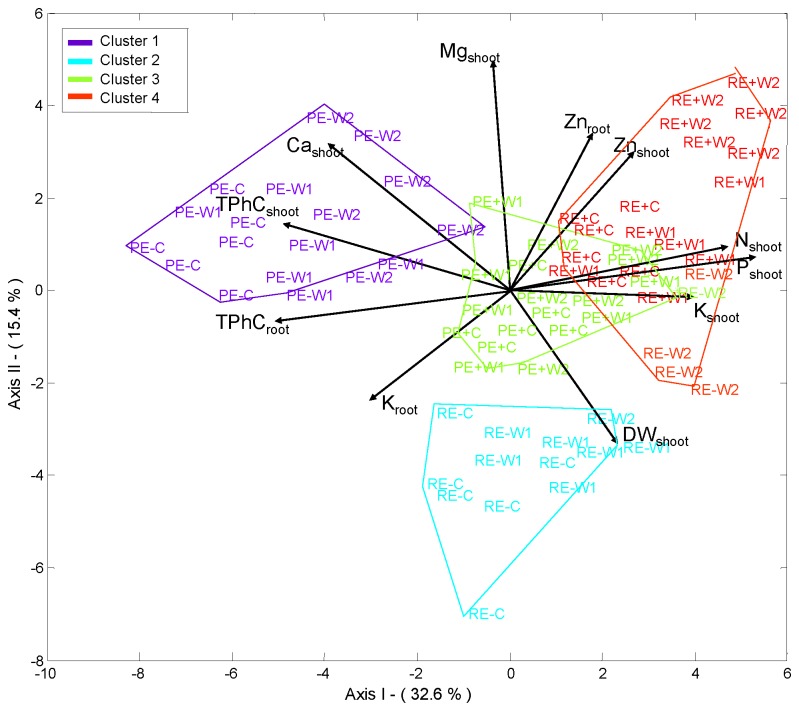
H-J biplot representation of samples and variables on the factorial plane I-II.Each sample was labelled with a first letter for plant line (P= PEN; R= RAB), a second letter for endophyte status (E+= endophyte infected; E-= non-infected), and a third letter for water treatment (C= control; W1= moderate stress; W2= severe stress).Variable labels: DWshoot = shoot biomass; DWroot=root biomass; TPhCshoot= total phenolic compounds in shoots; TPhCroot= total phenolic compounds in roots; Prolineshoot= proline in shoots; Prolineroot= proline in roots; and nutrient concentration in shoot and roots: Nshoot, Nroot, Pshoot, Proot, Kshoot, Kroot, Cashoot, Caroot, Mgshoot, Mgroot, Znshoot, Znroot.